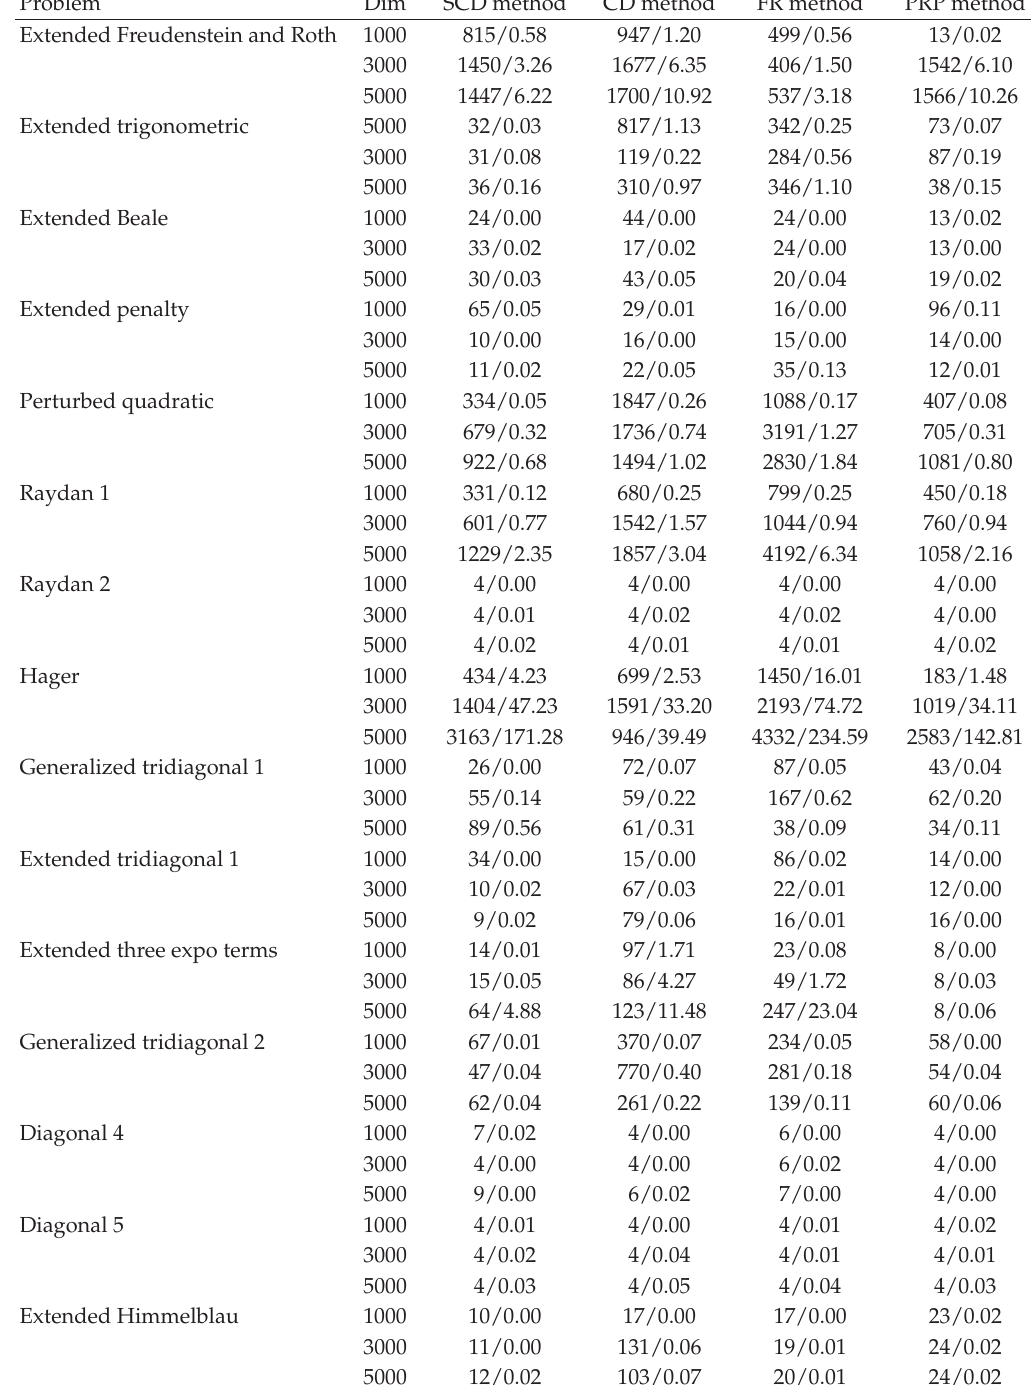
Table 1: The numerical results of SCD method, CD method, FR method, and PRP